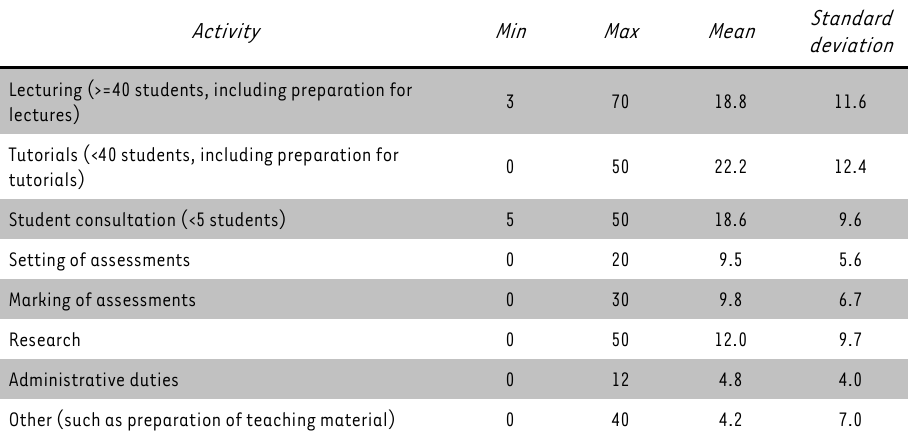
Ideal time spent on academic activities (percentage of total time) Activity Min